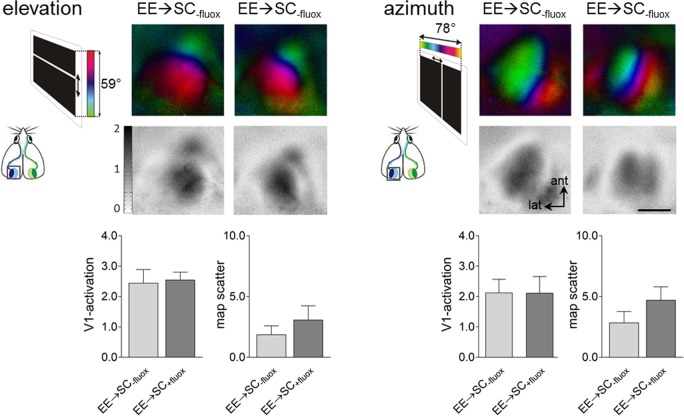
Fluoxetine treatment had no effect on V1-activation nor on the quality of the optically recorded V1-maps.Retinotopic polar and activity maps after visual stimulation with moving horizontal (elevation) or vertical (azimuth) bars (see inset to the left of the V1-maps) recorded from EE→SC mice control (water) or fluoxetine treatment, and their quantification. Comparison of V1-activation (lower left) and map quality (lower right) after contralateral (right) eye stimulation in both control (water, grey) and fluoxetine-treated (red) mice, for both elevation and azimuth stimulation. Recorded V1-maps of both treatment groups were indistinguishable in signal strength and retinotopic map quality. Scale bar: 1 mm.